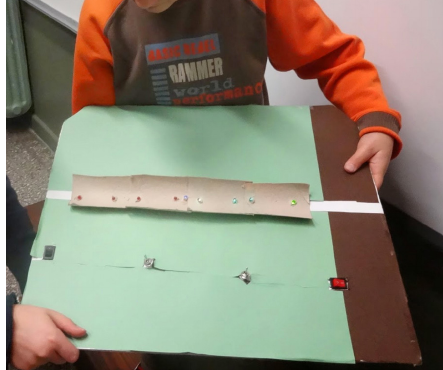
Fig. 5. Simple hands-on electronic